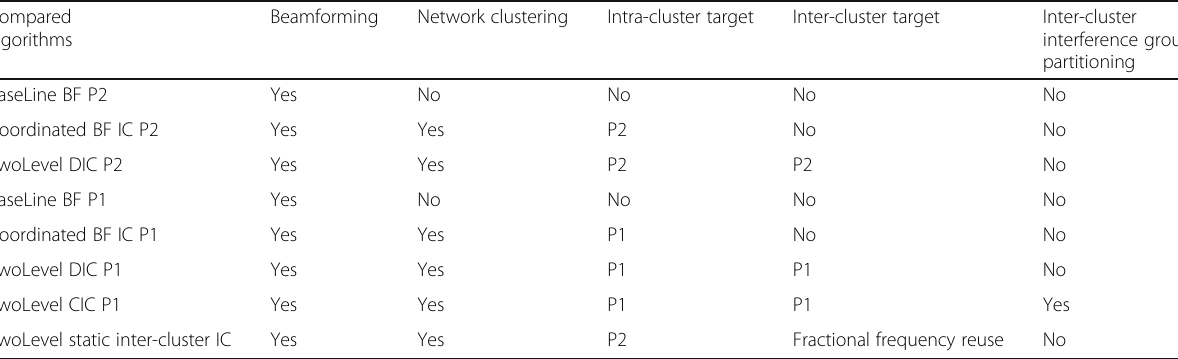
Beamforming Network